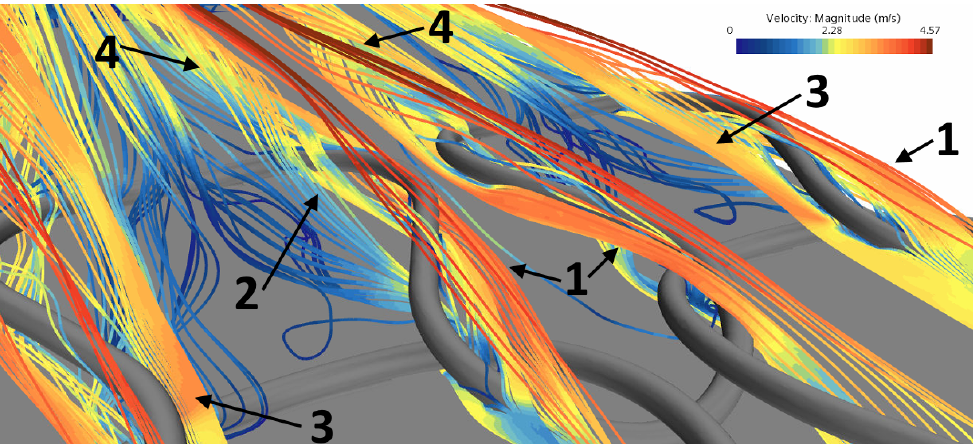
Figure 18. Streamlines around the knitted wire mesh with two rows. (1) Streamlines follow the curvature of the wire and extend from under the stitch towards the centerline. (2) Streamlines separate from 1, running inside of the stitch and over the wire towards the lateral outside of the stitch. (3) Streamlines running over the inside of the stitches. (4) Streamwise vortices emerging from 1, 2 and